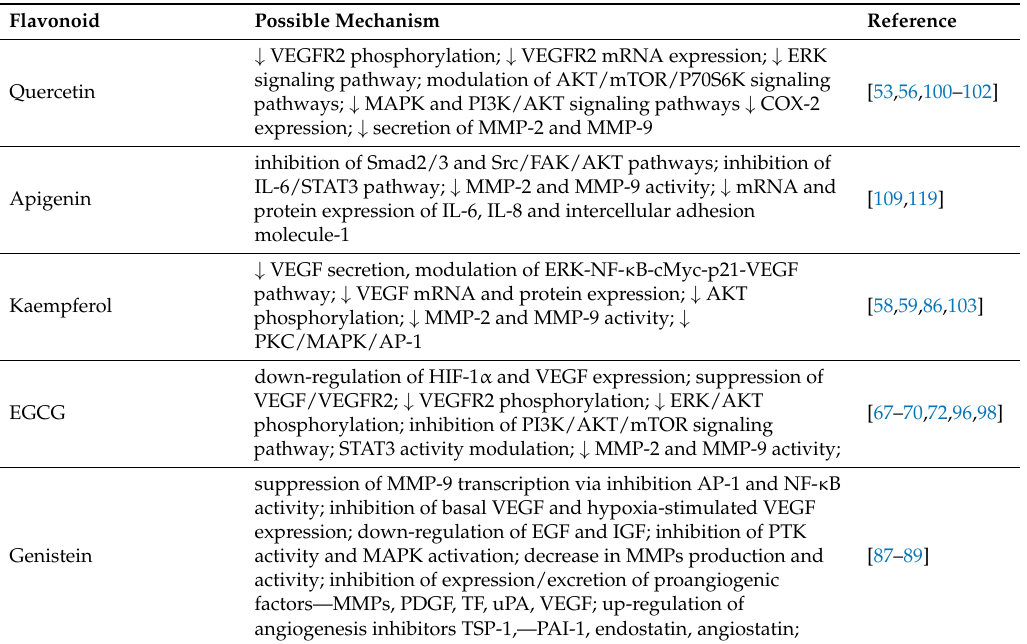
Table 2. Antiangiogenic effect of selected